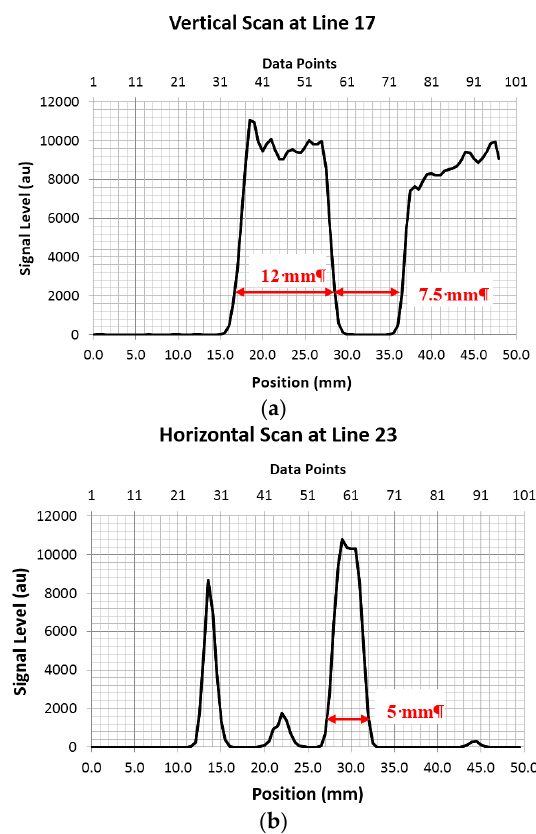
Figure 4. ( a ) A transmission image of a computer floppy disk; a scanned area of 50 mm × 50 mm at a resolution of 0.5 mm. The black lines indicate the single line scans at vertical line 17 and horizontal line 23; ( b ) is the photograph of the floppy disk flipped to correspond to scanned image.